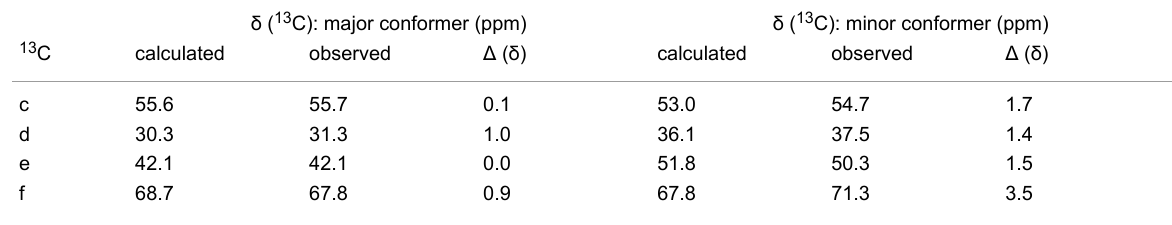
Table 2: Comparison of selected 13 C NMR data.